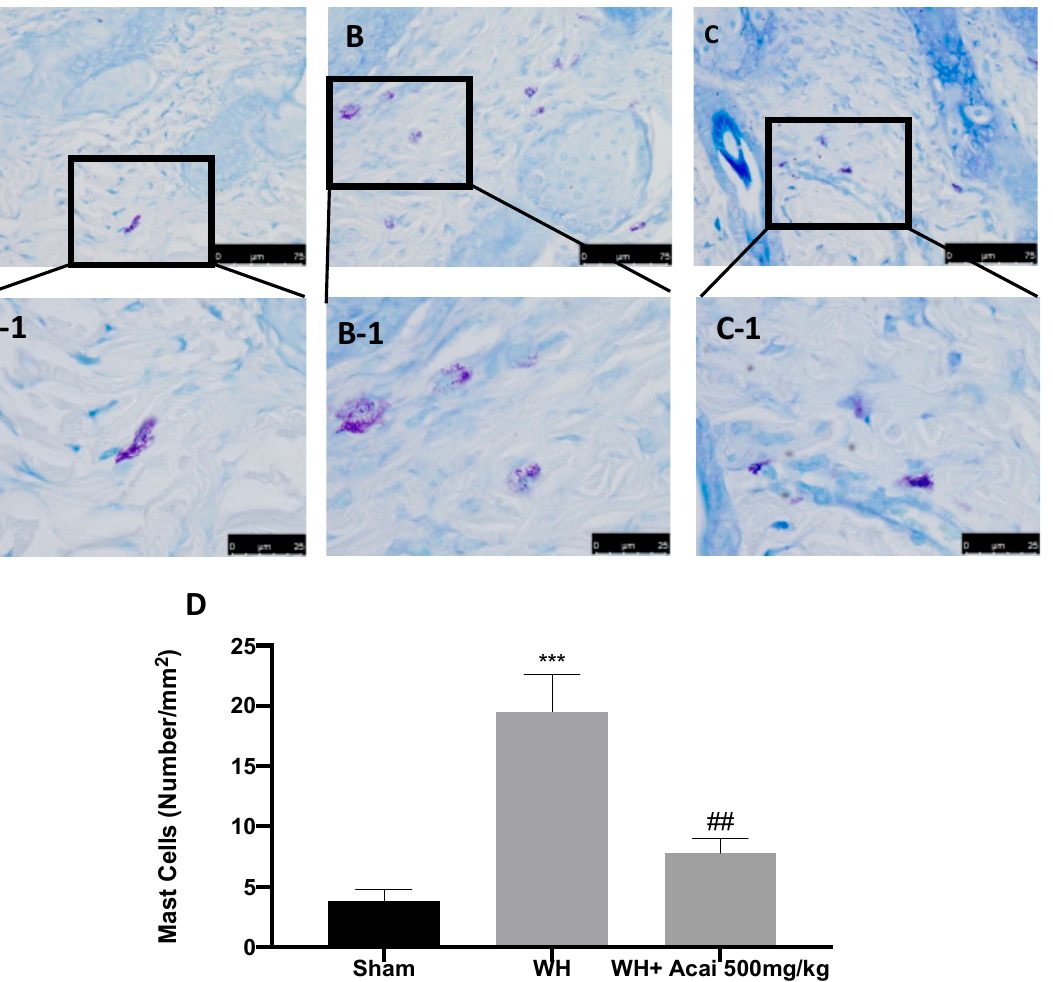
Figure 2. Mast cells indicated by toluidine blue staining: sham ( A , A-1 ), WH ( B , B-1 ), WH + açai berry ( C , C-1 ), mast cell count ( D ). A 75× magnification is shown (25 µm scale bar). A demonstrative blot of lysates with a densitometric analysis for all animals is shown. Data are expressed as the mean ± SEM of N = 6 mice/group. *** p < 0.001 vs. sham; ## p < 0.01 vs. WH.